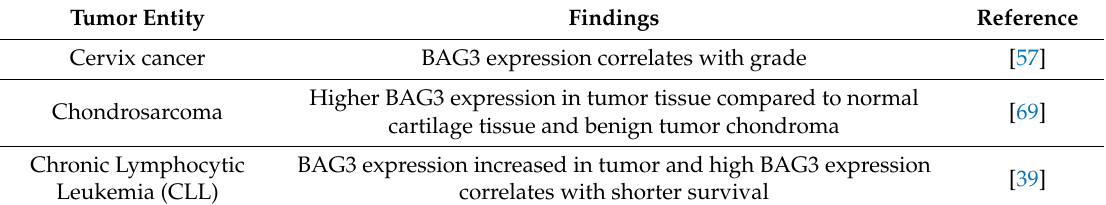
Higher expression compared to adjacent non-tumor tissue; females have higher BAG3 expression; large tumors ( > 5 cm) have higher BAG3 expression Higher expression of BAG3 compared to adjacent healthy